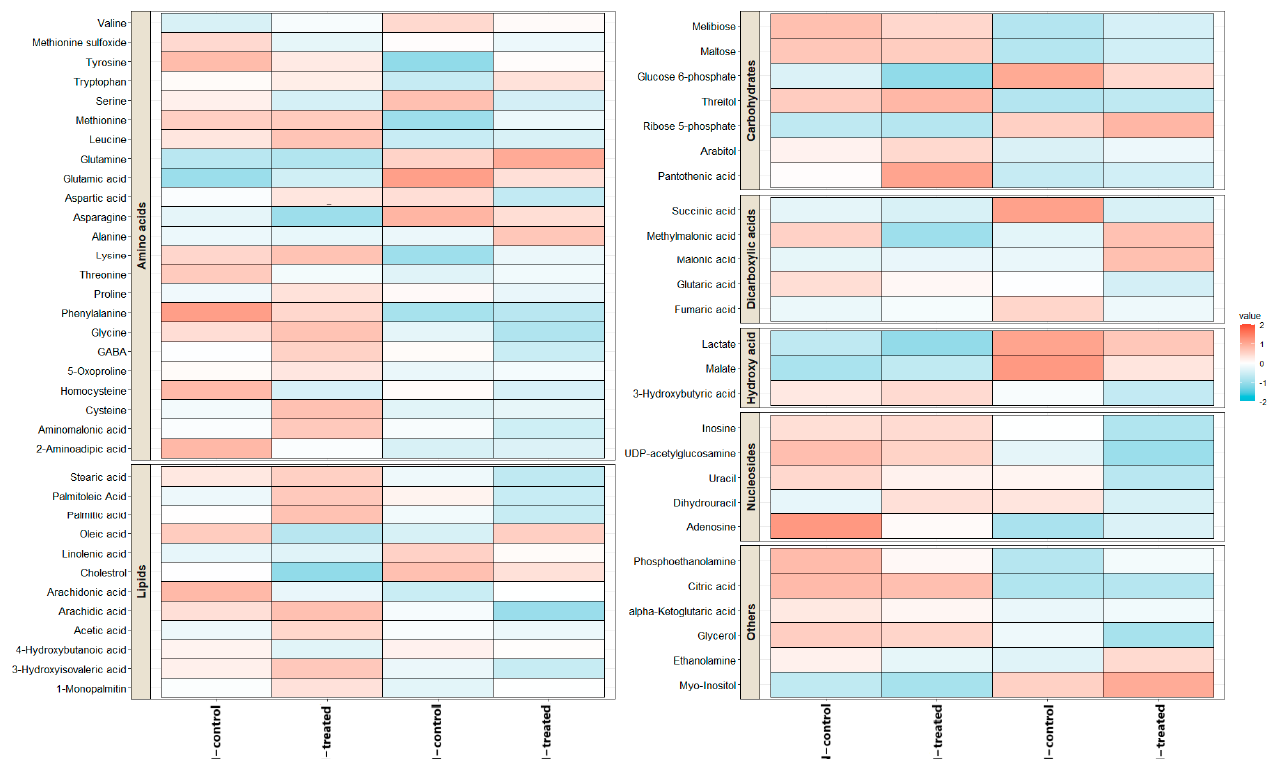
Figure 2. The heatmap shows how the metabolites vary in normal and high-glucose condition with and without PEDF. Identified metabolites were compared based on their average intensities. Red colours indicate increased values, while blue colours indicate decreased values. Key: H, high glucose; N, normal glucose. Table 1. Significantly altered metabolites among groups in normal and high-glucose conditions with and without PEDF using a one-way ANOVA and Tukey’s HSD